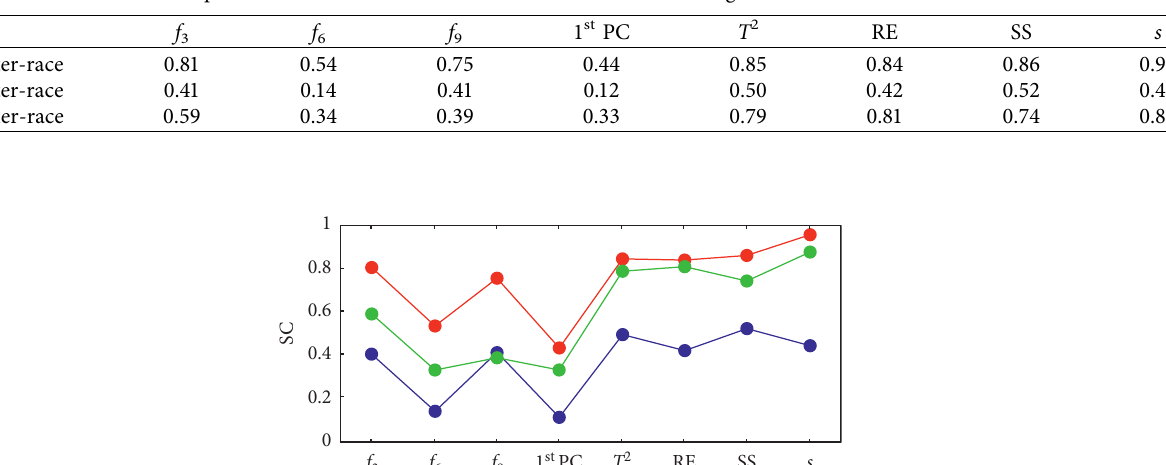
Figure 7: The cycle-life bearing PDA results of the proposed feature clustering chart based on the reference Table 3: Spearman coefficients of different HIs for different bearing failure on its whole life time.